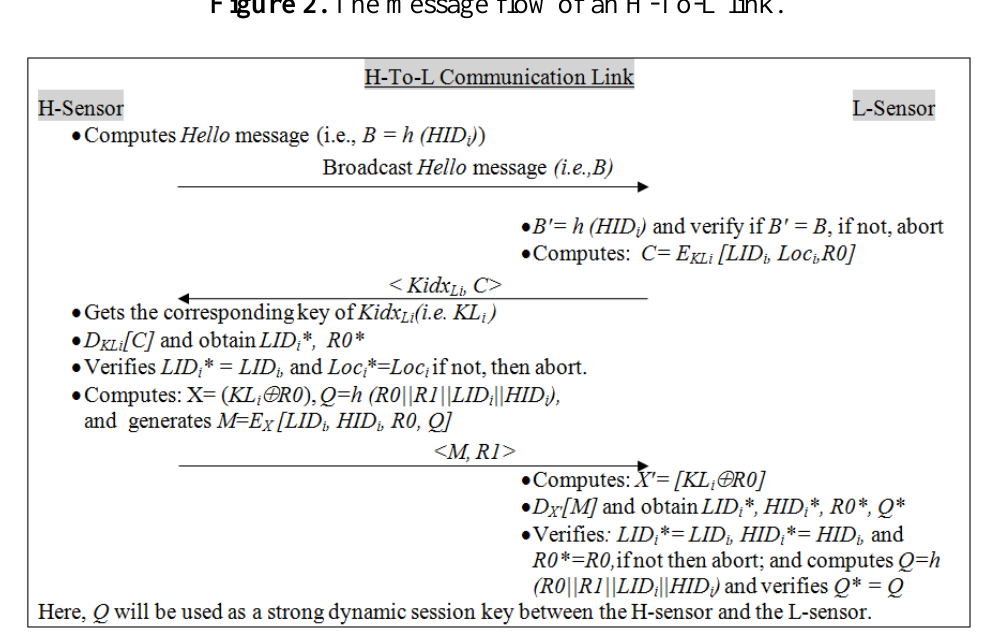
Figure 2. The message flow of an H-To-L